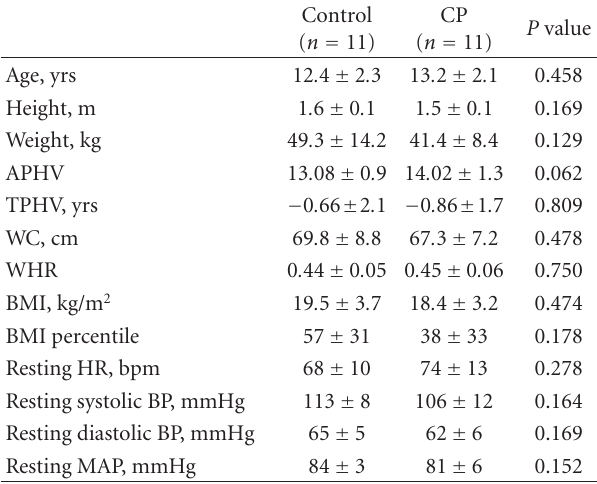
Table 1: Subject